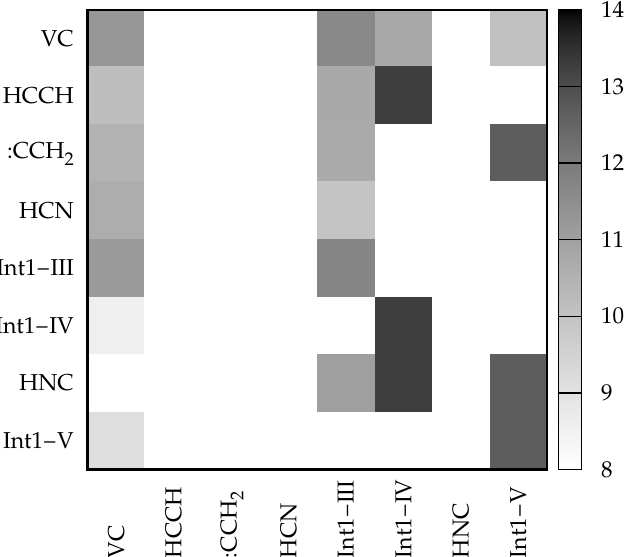
Figure 10. Color map of the transition K matrix at energy E = 62000 cm − 1 relative to the reactant zero-point energy as visualized in the VMS software. For each element of the matrix, the value of | log K ij | in s − 1 is plotted according to the gray scale on the right-hand-side of the plot 10